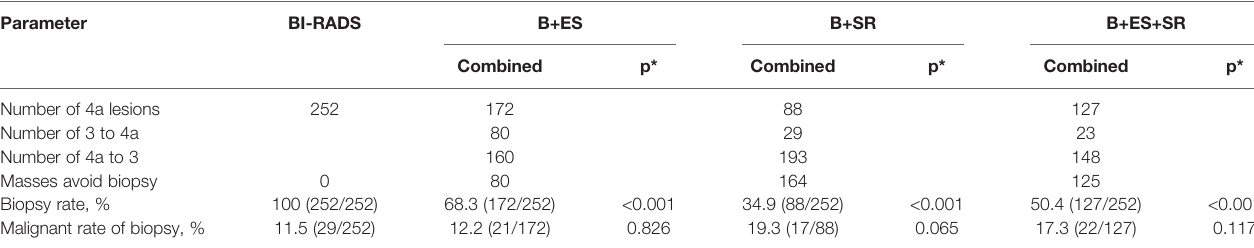
TABLE 6 | The value of ES and SR in reducing biopsy of BI-RADS 4a